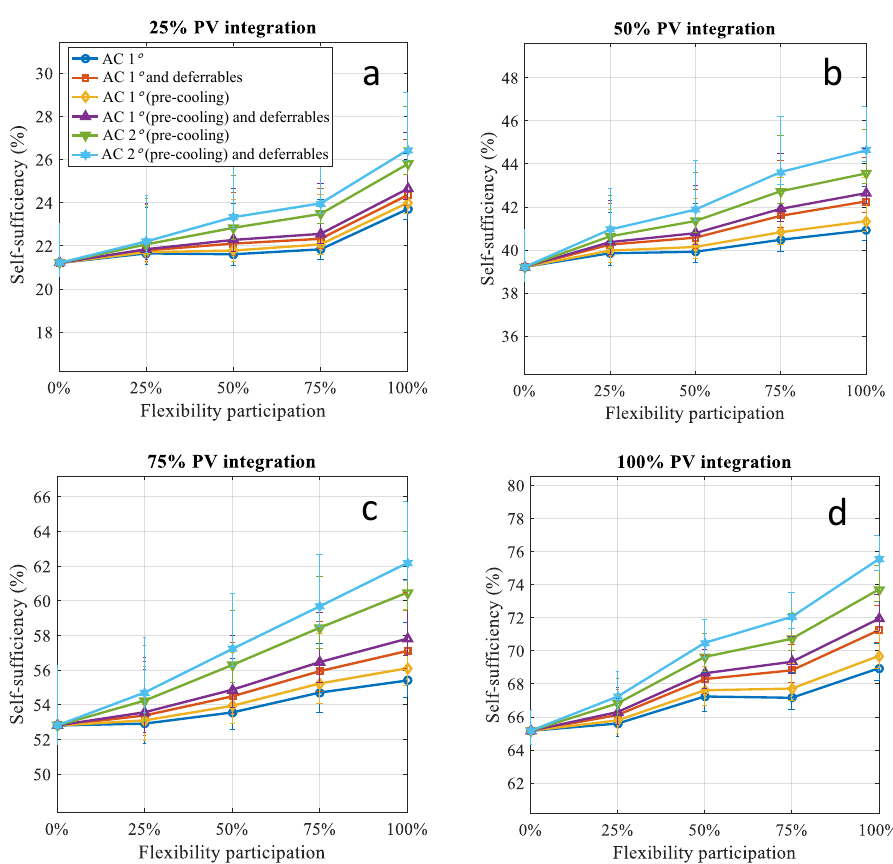
Figure 12. Impact of flexible (adaptive) behavior on self-sufficiency through load profile change